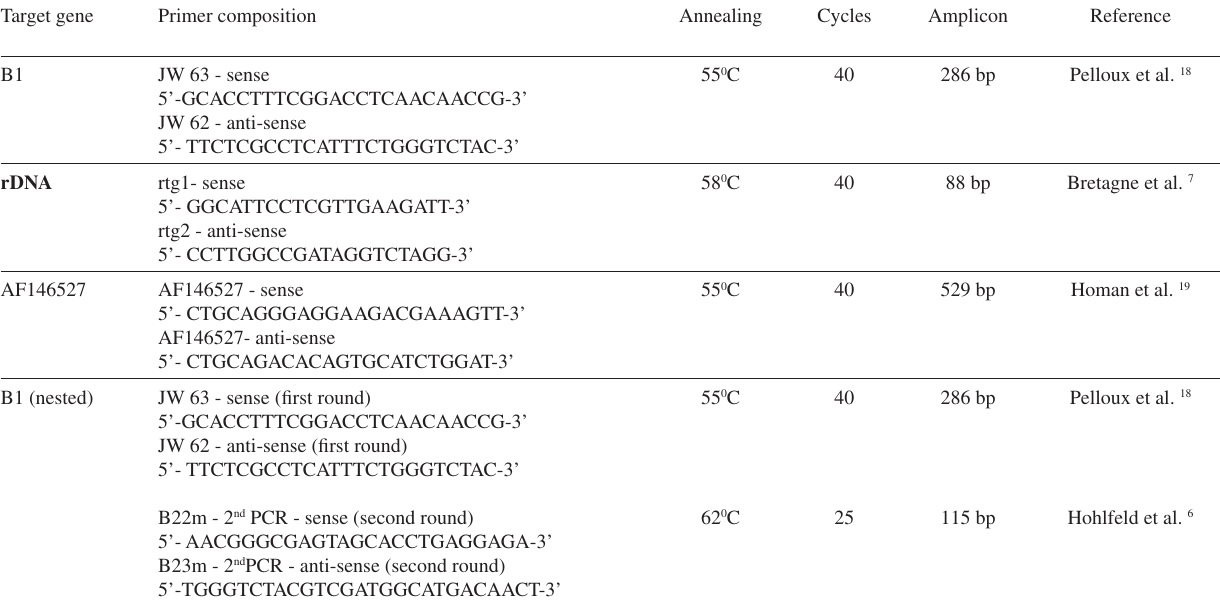
Table 1 - Description of the four PCR systems used in the present study Target